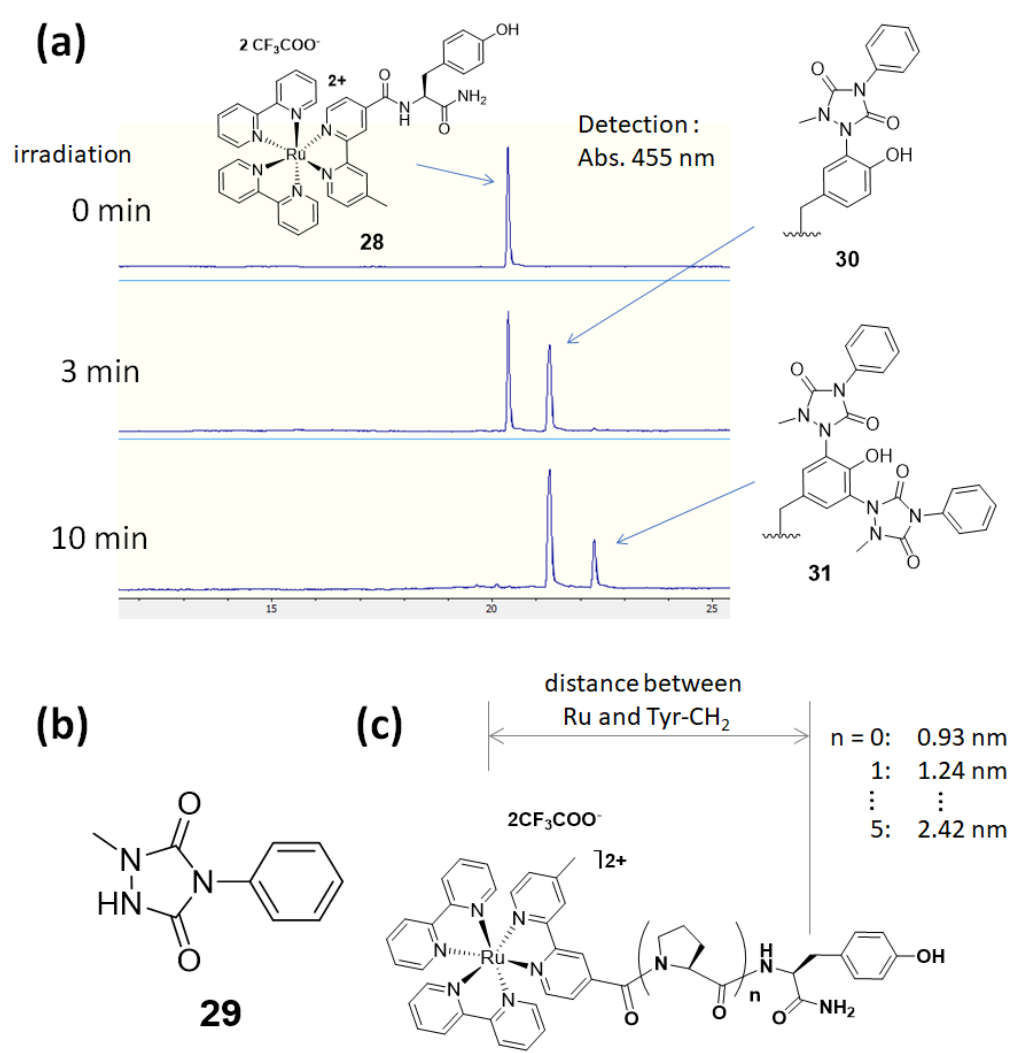
Figure 9. Photocatalyst-proximity tyrosine labeling. ( a ) Model substrate 28 was labeled with 29 . ( b ) Structure of labeling agent MAUra 29 . ( c ) Model substrate with a rigid proline linker with a distance of several nanometers between ruthenium and tyrosine.